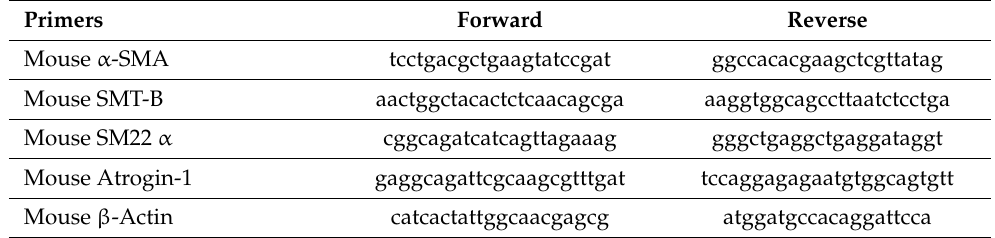
Table 1. Sequences of gene-specific primers used in